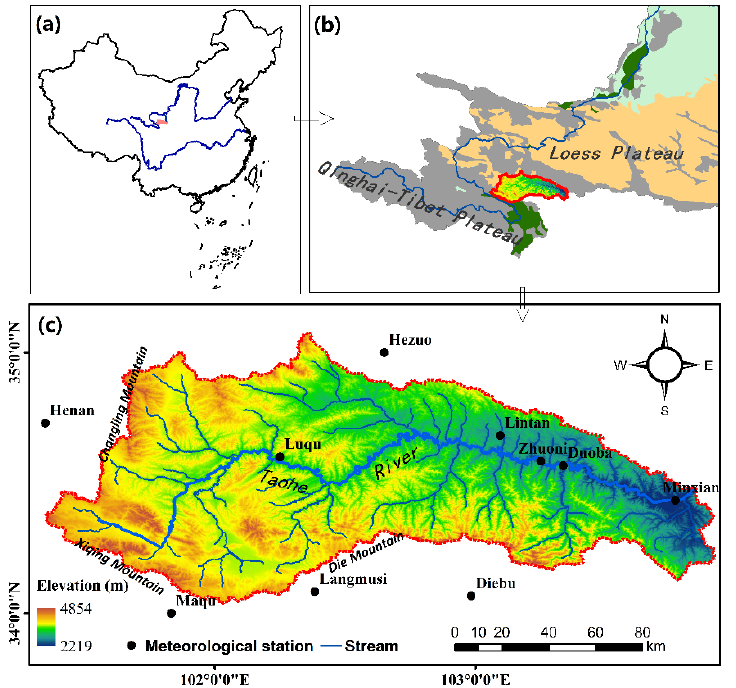
Figure 1. ( a ) Upper Taohe River Basin in China ( b ) Upper Taohe River Basin between Qinghai-Tibet Plateau and Loess Plateau ( c ) Topographical and geomorphic map of upper Taohe River Basin.